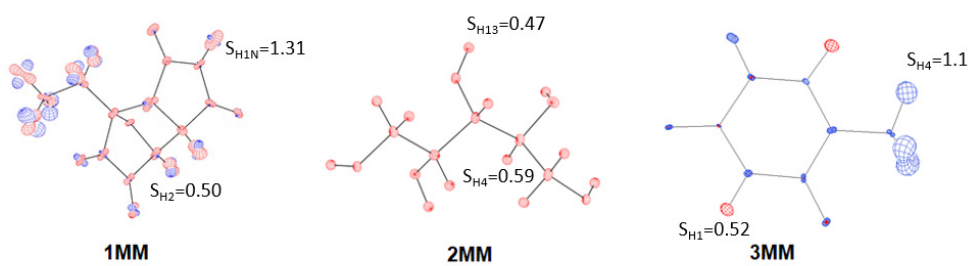
Figure 2. Differences between ADP values resulting from neutron and MM refinements for 1 , 2 , and 3 . PEANUT plots for HAR_aniso, HAR_NoMoRe, HAR_SHADE, and TAAM_SHADE are available in the Supplementary Materials (Figures S27–S29). Scale is equal to 2.0. The colour red represents ADPs larger than neutron ADPs, whereas blue represents ADPs smaller than neutron ADPs. Selected values of similarity index (S HX , where x is an atom number) were added to the plots.